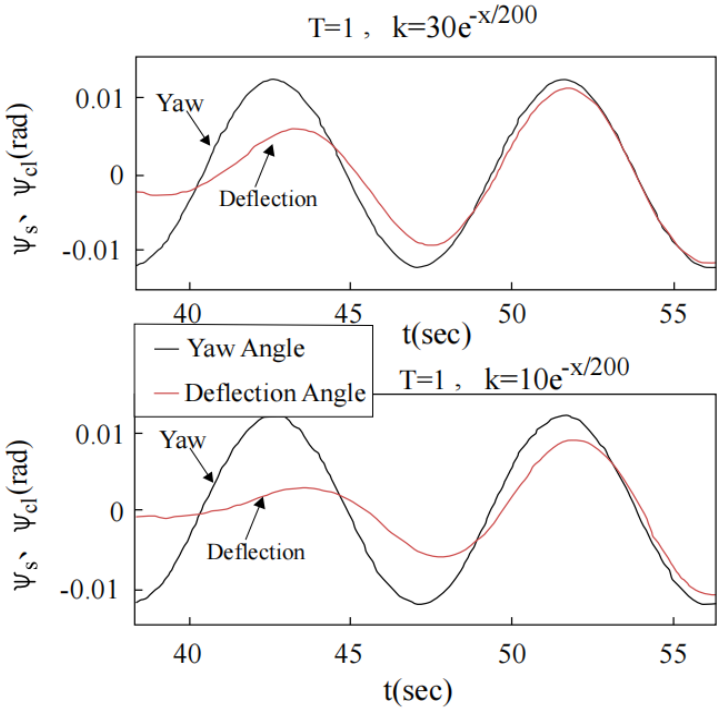
Figure 40. Tracking response curves of measurement axis under inertial tracking strategy with static coefficients of different k values.